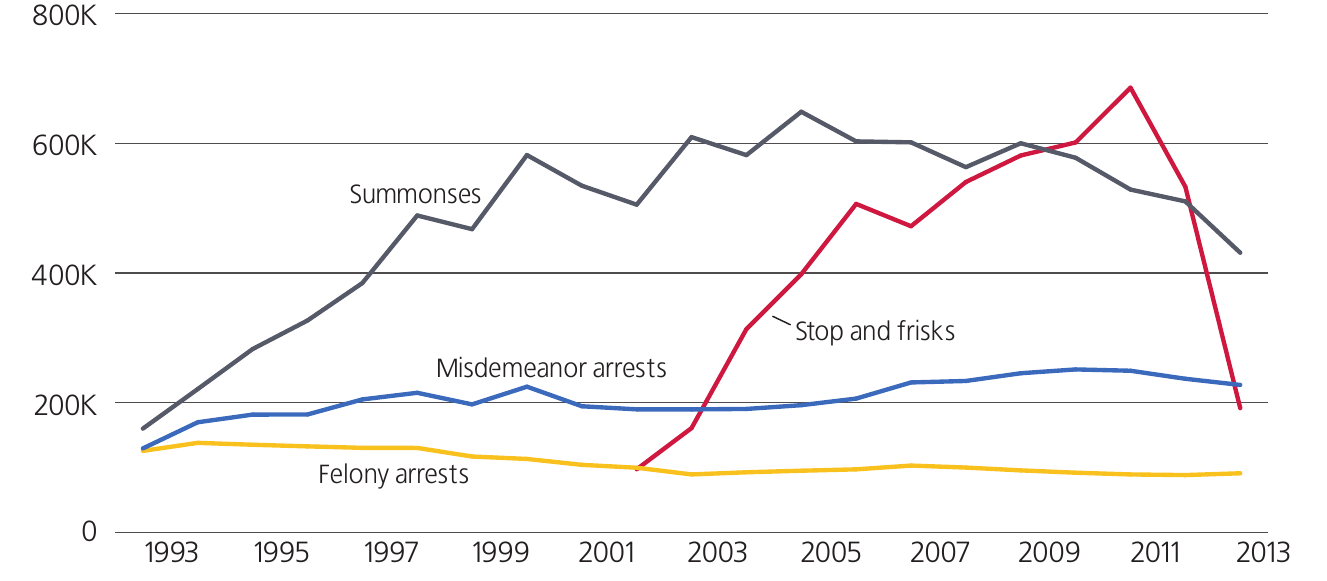
Figure 3. Summonses, misdemeanor arrests, stop and frisks, and felony arrests since